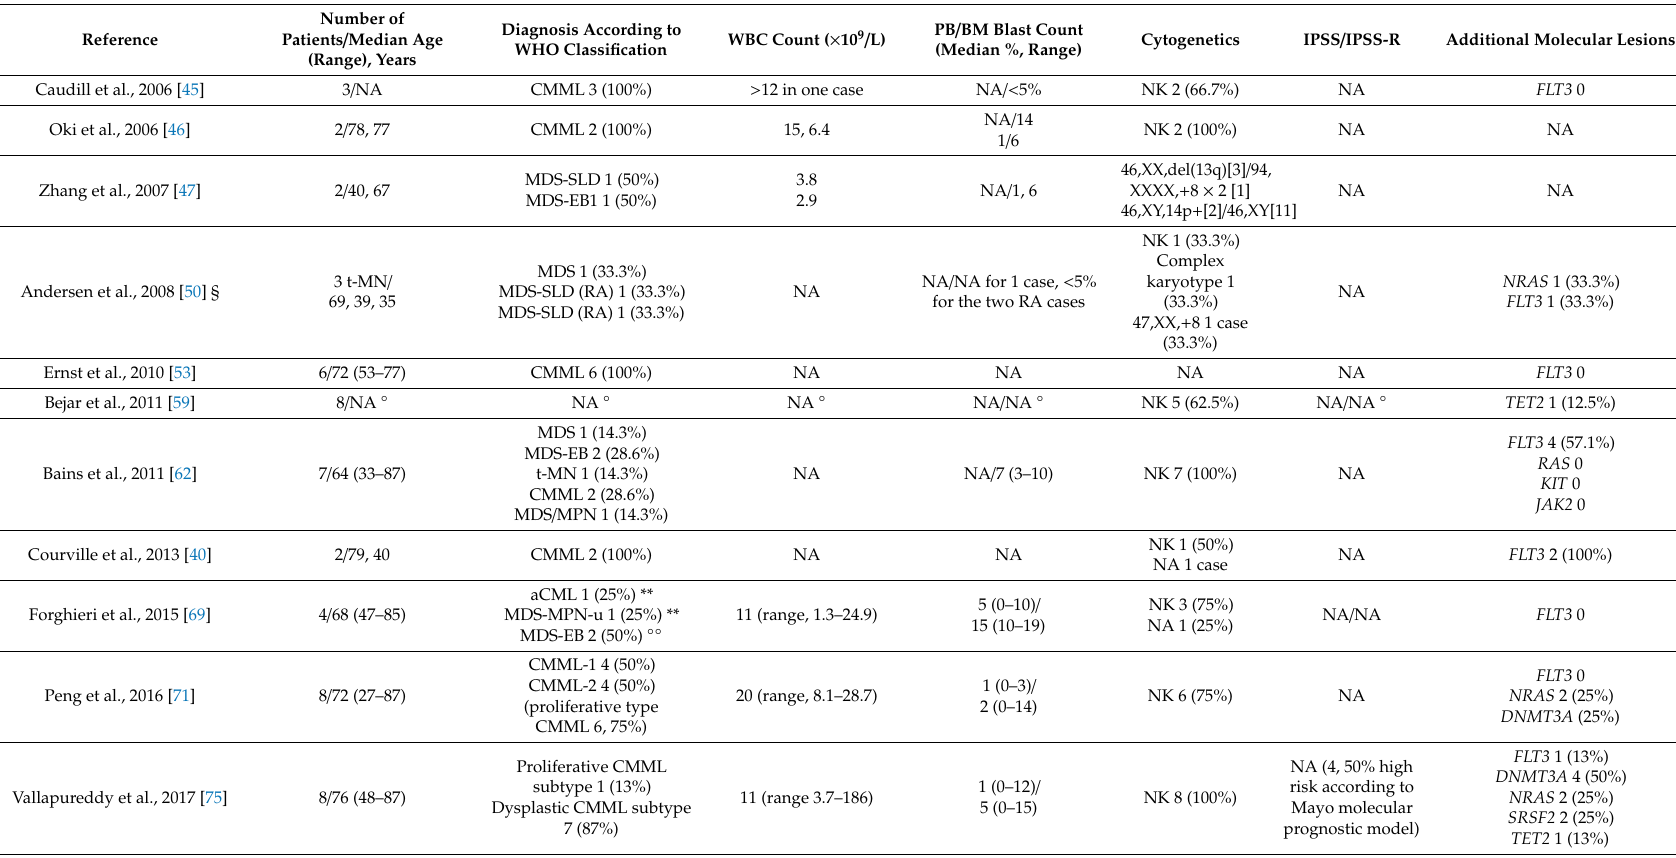
Table 2. Clinical characteristics and prognostic features of NPM1 -mutated MNs with < 20% blasts: review of the